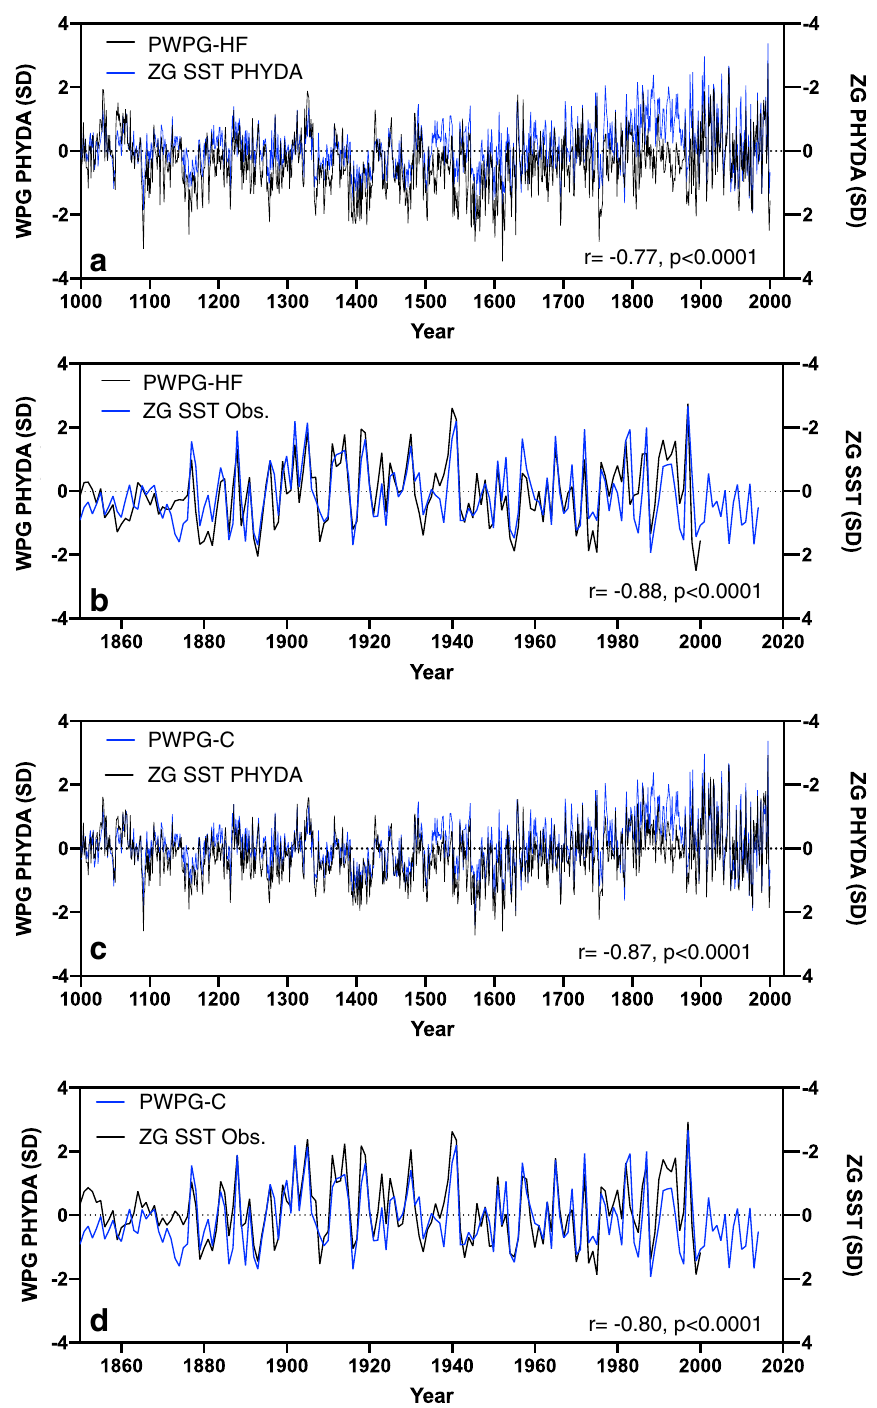
Figure 2. Reconstructed and Observed zonal (West–East) Pacific SST Gradient (ZG) compared to West Pacific Gradient (WPG) reconstructions. Time series were normalised relative to 1961–1990 (SD = standard deviation). PWPG-HF reconstruction compared with ( a ) PHYDA zonal SST gradient after Coats and Karnauskas 9 , ( b ) observed zonal SST gradient from COBE2 SST (axis inverted 57 ) after Coats and Karnauskas 9 . PWPG-C reconstruction compared with ( c ) PHYDA zonal SST gradient after Coats and Karnauskas 9 and ( d ) observed zonal SST gradient after Coats and Karnauskas 9 from COBE2 SST (axis inverted 57 ). Correlation coefficients (year to year) are indicated over full period of overlap for detrended